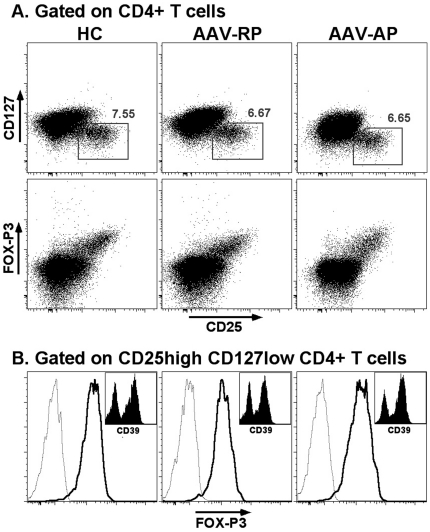
Characterization of Treg using flow cytometry in controls and patients.
A, Expression of CD25, CD127 and FOX-P3 in CD4+ T cells. Representative dot plots for healthy controls (HC), AAV patients in remission phase (AAV-RP) and AAV patients in acute phase (AAV-AP) showing CD25 vs. CD127 and CD25 vs. FOXP3 expression in gated CD4+CD3+ T cells are shown. The gate use to identify Treg in fresh blood is shown in each CD25 vs. CD127 dot plot. B. Representative histograms showing expression of FOX-P3 (bold line) vs. isotype control (dotted line) and CD39 (inset) in CD4+CD25highCD127 low cells as gated in A.